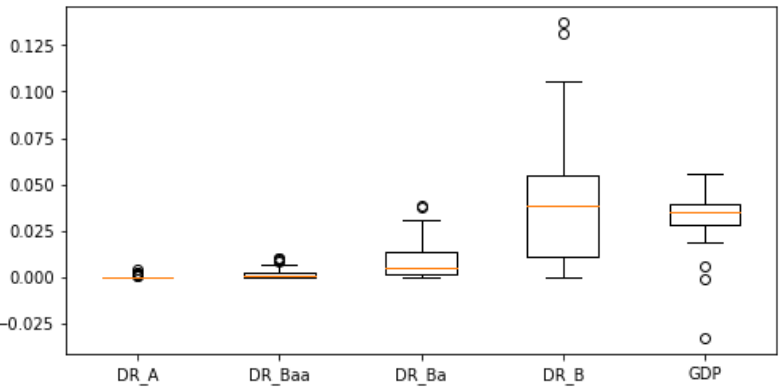
Figure 1. Boxplots of default rates on rating classes [A, Baa, Ba, B] and GDP.